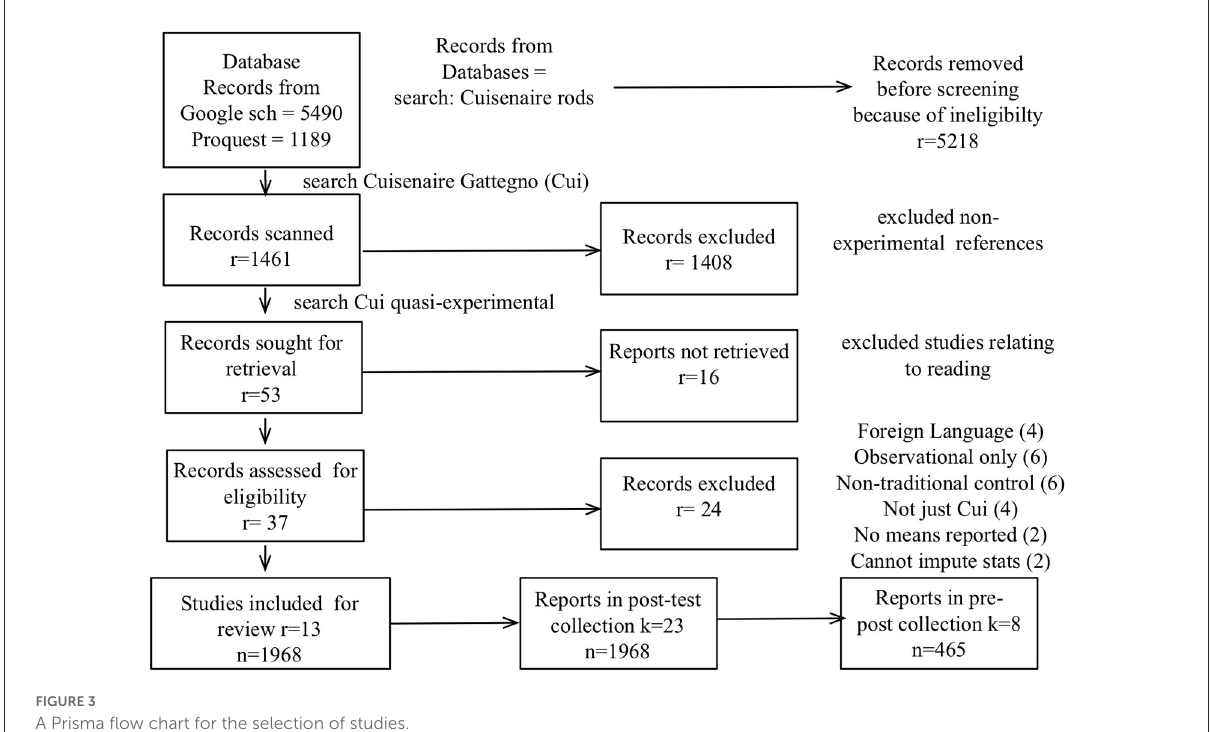
FIGURE3 A Prisma flow chart for the selection of studies.